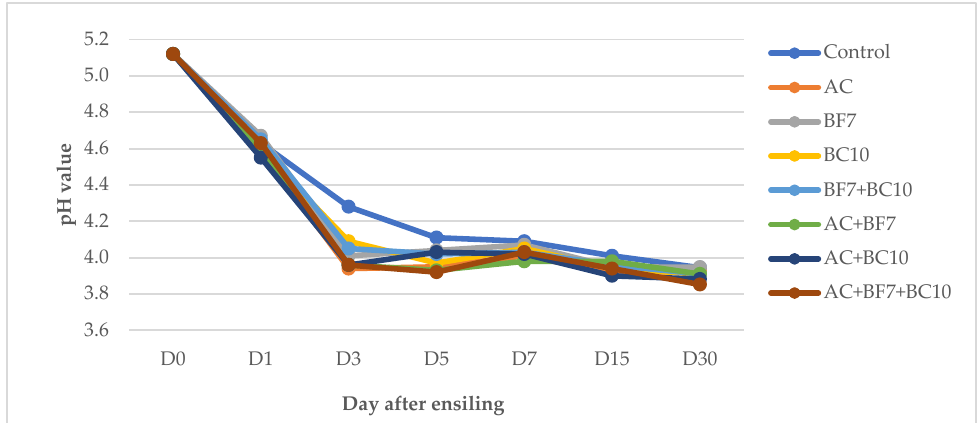
Figure 2. The changes in pH value of cassava root silage during 30 days of ensiling. AC — Acremonium cellulase; BF7 — E. feacium KKU-BF7 inoculant ; BC10 — E. gallinarum KKU-BC10 inoculant.